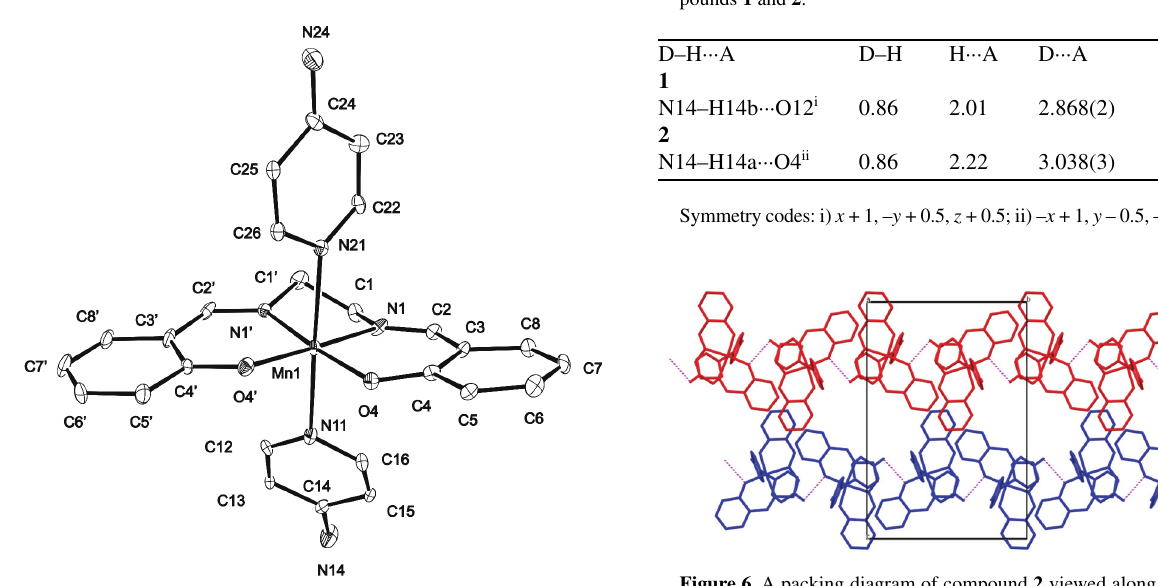
Figure 4. An ORTEP view of a cation in compound 2 , [ Mn(4- apy) (sal) ] PF , showing the 30% probability ellipsoids and the la- 2 6 beling scheme for non-hydrogen atoms. Hydrogen atoms are omit- ted for clarity.